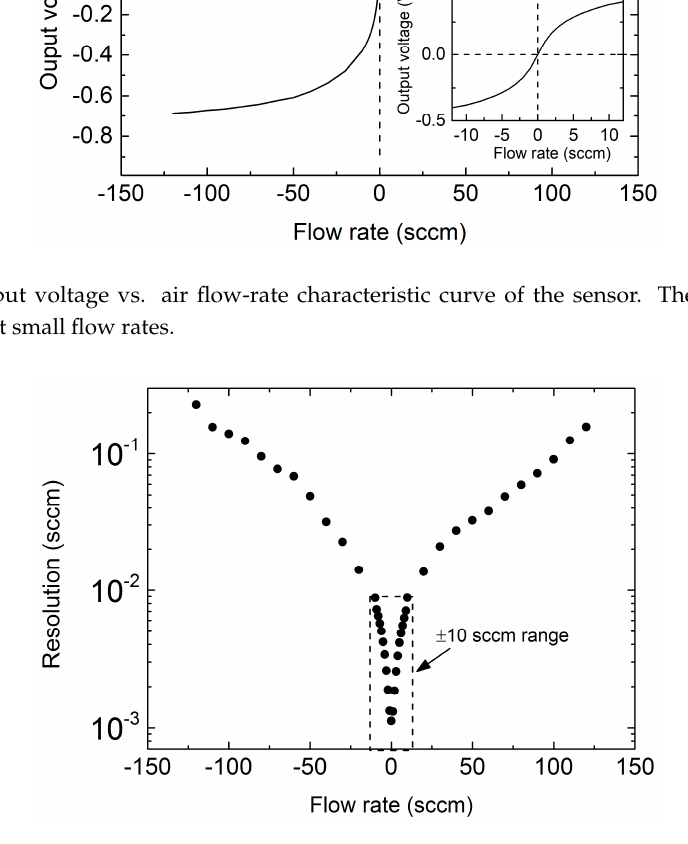
Figure 9. Sensor resolution as a function of flow rate. Resolution is reliably better than 10 − 2 sccm throughout the ±10 sccm interval, indicated by the dashed box.